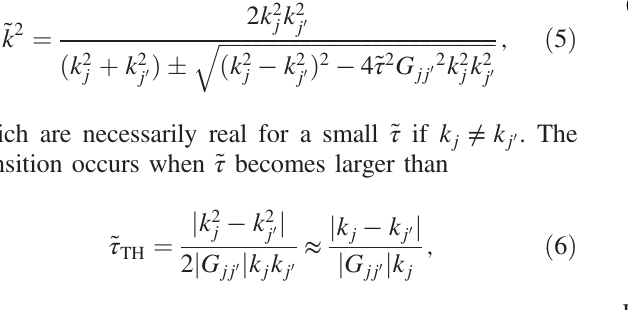
FIG. 2. Protected PT transitions and an entirely real spectrum at small τ with additional discrete symmetries. (a) Three pairs of broken-symmetry modes are shown, and complex eigenvalues ≃ 0 . 047 . Inset: The symmetries only appear above the lowest τ TH of the system are described by the generalized dihedral group DT 6 (see Sec. III C). It includes, for example, P 2 v with v ¼ π = 2 and R 2 π in addition to the PT symmetry. Here, P ϕ denotes the = 3 parity operation about the ϕ ; ϕ þ π axis, and R ϕ denotes clockwise rotation about the origin by ϕ . (b) Intensity profiles of the four broken-symmetry modes marked in (a) at τ ¼ 0 . 16 . The broken-symmetry modes can be nondegenerate (e.g., modes A and B ), in which case they are simultaneous eigenfunctions of P R 1 and π = 2 and 2 π = 3 ; they can also be degenerate (e.g., modes C C 2 ), in which case they can either be eigenfunctions of P π or = 2 1 and C 2 plotted are eigenfunctions R 2 π = 3 but not both. Modes C of P π , and they can be linearly combined to be eigenfunctions = 2 of R 2 π = 3